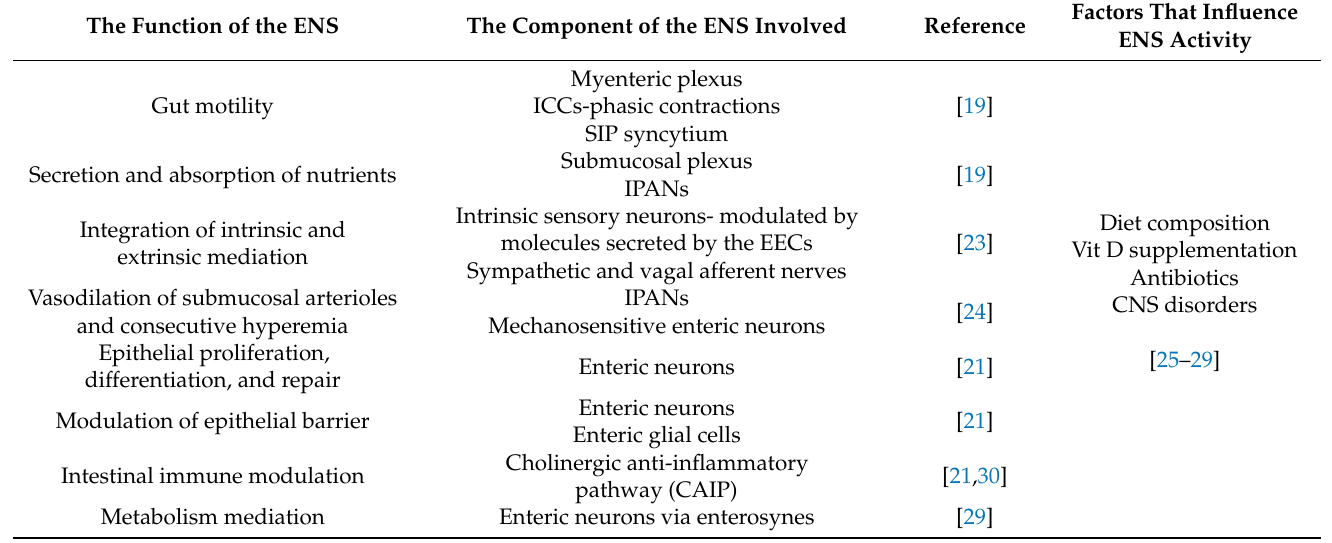
Table 1. Main functions of Enteric Nervous System and their influencing factors. Abbreviations: CNS, Central Nervous System; ICC, interstitial cells of Cajal; EECs, Enteroendocrine Cells; IPAN, intrinsic primary afferent